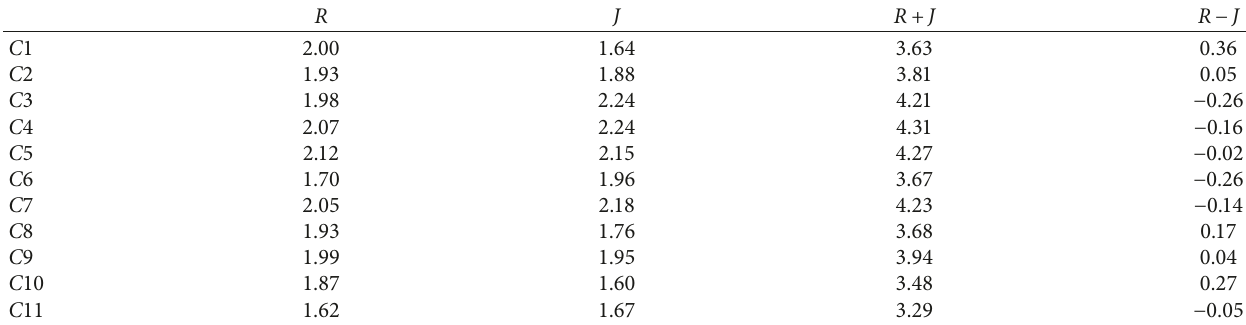
Table 6: Values ( J ), ( R ), ( R + J ), and ( R − J ) in a nonfuzzy form (definite).